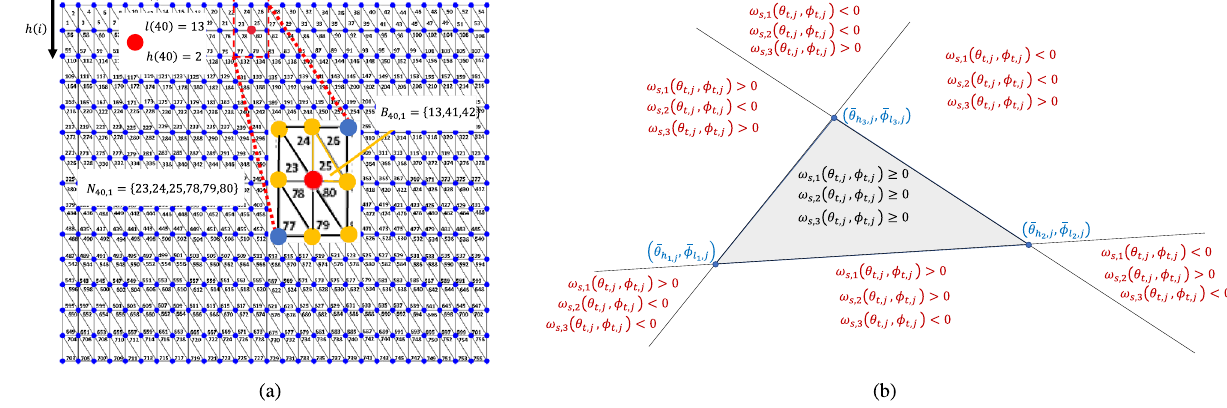
Figure 2. ( a ) The indexing method used to provide reference for each boundary node i ∈ B j and j ∈ C shown in Fig. 1a. ( b ) Discretization of the θ − φ plane based on the signs of components of vector (cid:31)